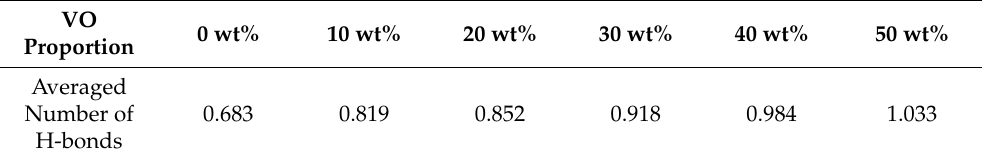
Table 8. The average number of H-bonds per water molecule in mixed oil models with 1wt% of water content.